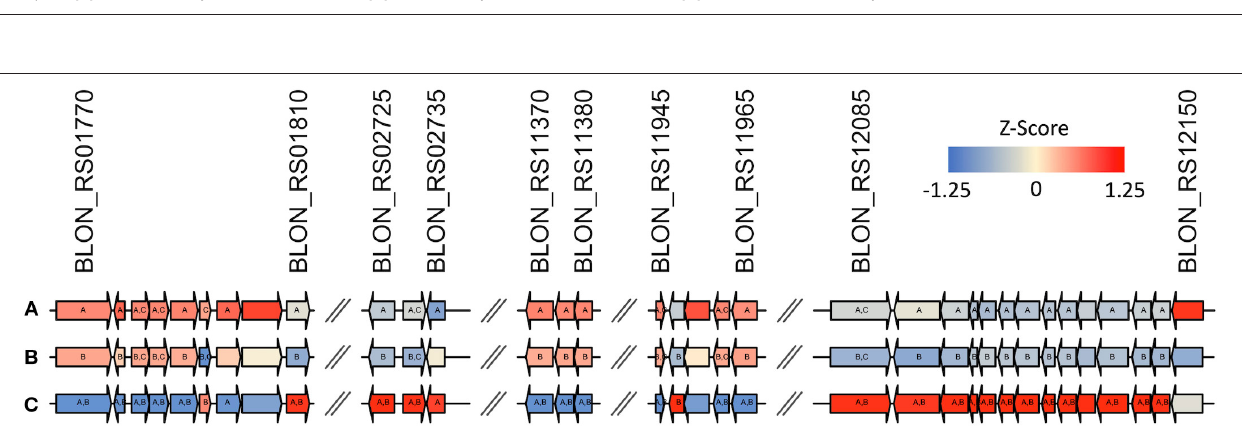
FIGURE 5 | B. infantis gene expression is similar during growth on 0.8% and 2% 2 ′ fucosyllactose as compared to during growth on lactose as seen from (A) sample-to-sample distance. While gene regulation is similar, there are several genes that show concentration-dependent regulation when volcano plots are used to compare (B) 0.8% 2 ′ fucosyllactose and lactose, (C) 2% 2 ′ fucosyllactose and lactose, and (D) 0.8% and 2% 2 ′ fucosyllactose.